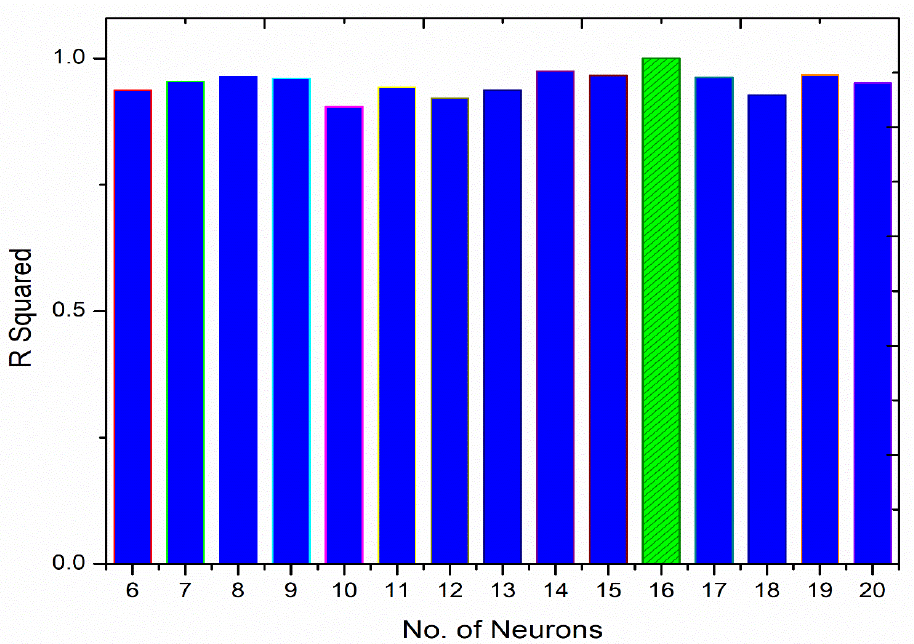
Figure 5. Variation of R 2 value over number of hidden neurons.